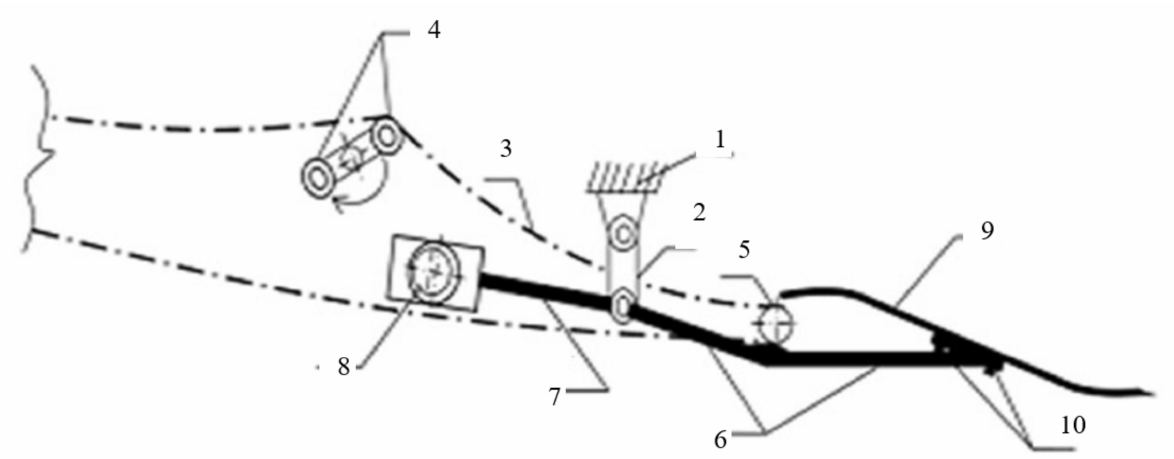
Figure 4. Scheme of separating rod elevators: 1, frame; 2, thrust; 3, rod elevator; 4, double-shoulder shaker; 5, support roller; 6, mounting bracket; 7, intermediate bracket; 8, eccentric shaft; 9, scrounging; 10,